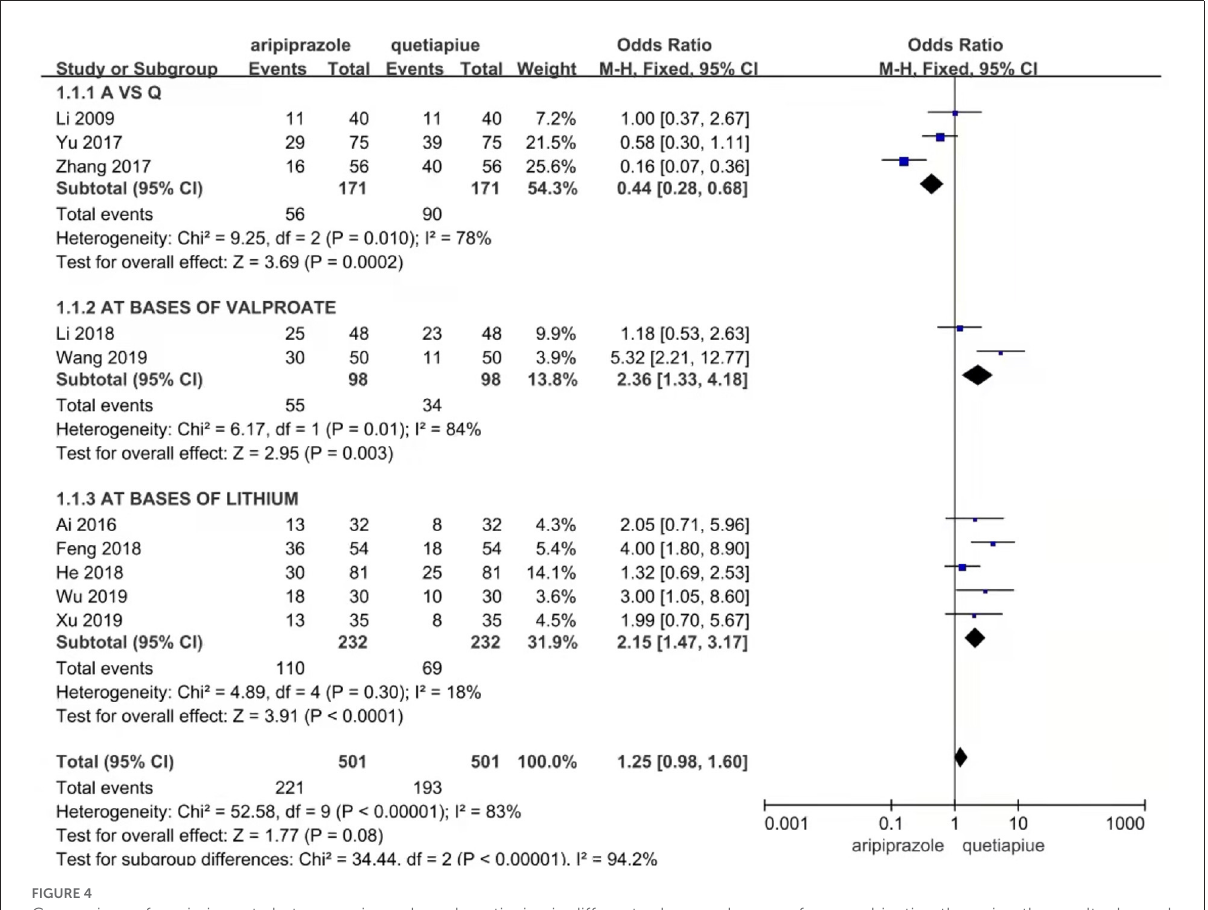
FIGURE4 Comparison of remission rate between ariprazole and quetiapine in different subgroup. In case of no combination therapies, the results showed that the remission rate of aripiprazole was significantly lower than quetiapine in the treatment of bipolar depression (56/171 vs. 90/171, Z = 3.69, P = 0.0002) by random effect model. In case of combination therapies with valproate sodium, the results showed that the remission rate of aripiprazole was significantly higher than quetiapine in the treatment of bipolar depression (55/98 vs. 34/8, Z = 2.95, P = 0.003) by random effect model. In case of combination therapies with lithium carbonate, the results showed that the remission rate of aripiprazole was significantly higher than quetiapine in the treatment of bipolar depression (110/232 vs. 69/232, Z = 3.91, P < 0.0001) by fixed effect model.